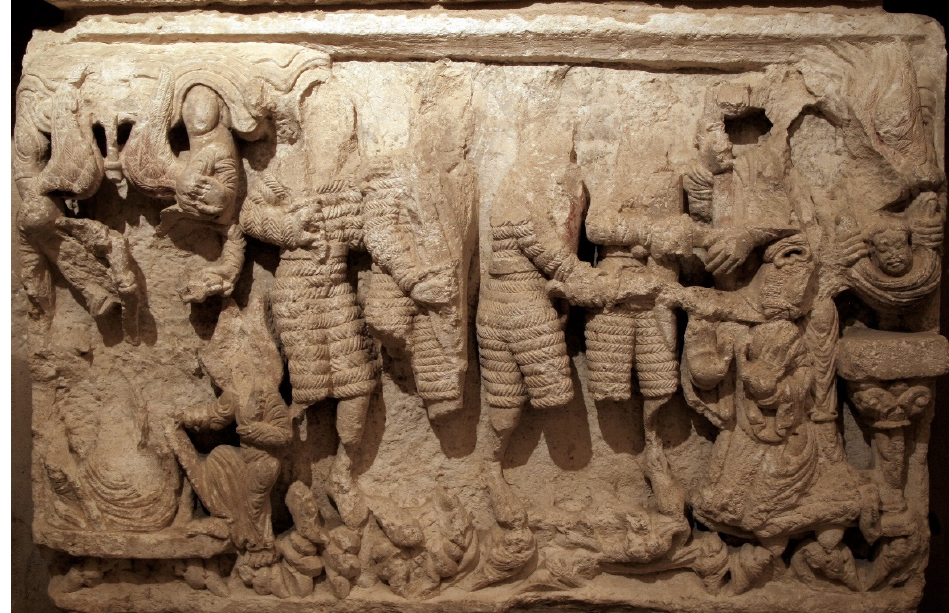
Figure 1. Almazán. Church of San Miguel. Frontal of Thomas Becket’s martyrdom.